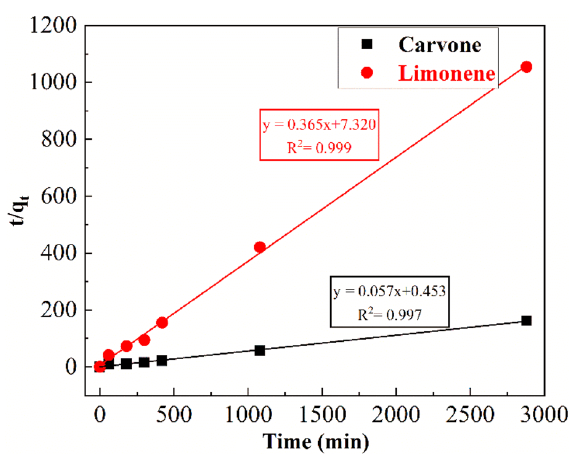
Figure 7. Pseudo-second-order kinetic model of Carvone and Limonene adsorption on purified montmorillonite.